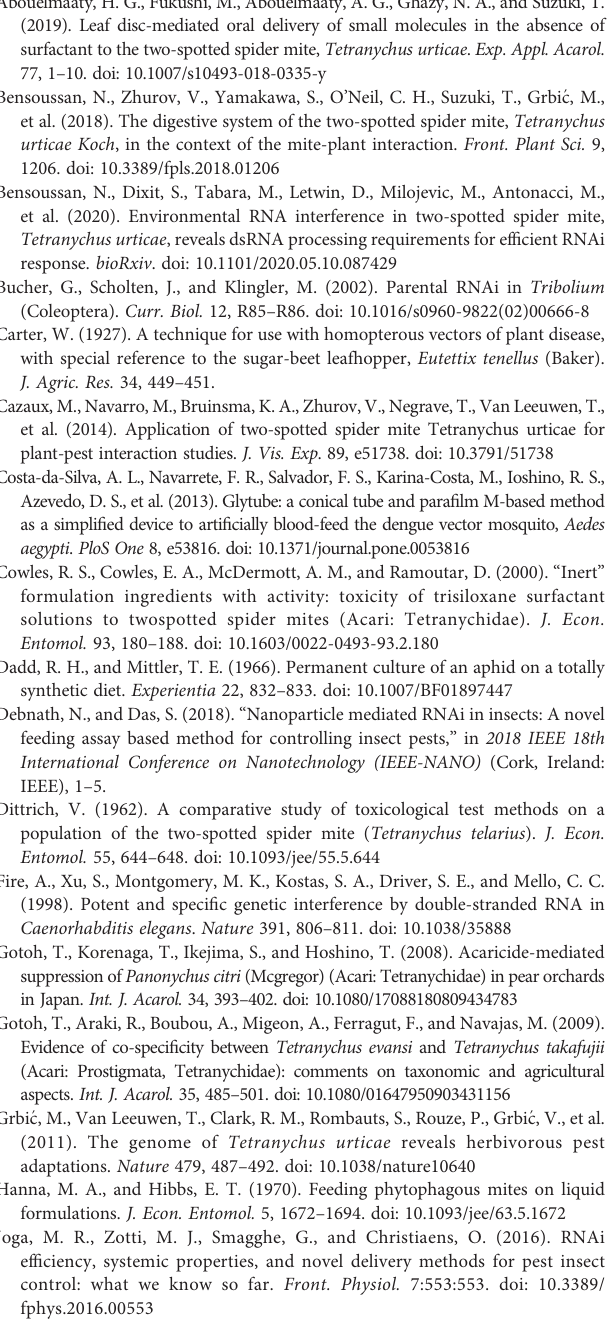
VIDEO S3 | Adult Tetranychus urticae females ( n = 50) sucking on 18-ppm abamectin in 1% (w/v) blue tracer dye (Brilliant Blue FCF) solution in the mesh method feeding device for 2.5 h. Thevideo is shown at 128×speed. Feeding arena: 4 × 3 mm. VIDEO S4 | Aphis gossypii nymphs sucking on 2.5% (w/v) blue tracer dye (Brilliant Blue FCF) solution in the mesh method feeding device for 16 min. The video is shown at 32×